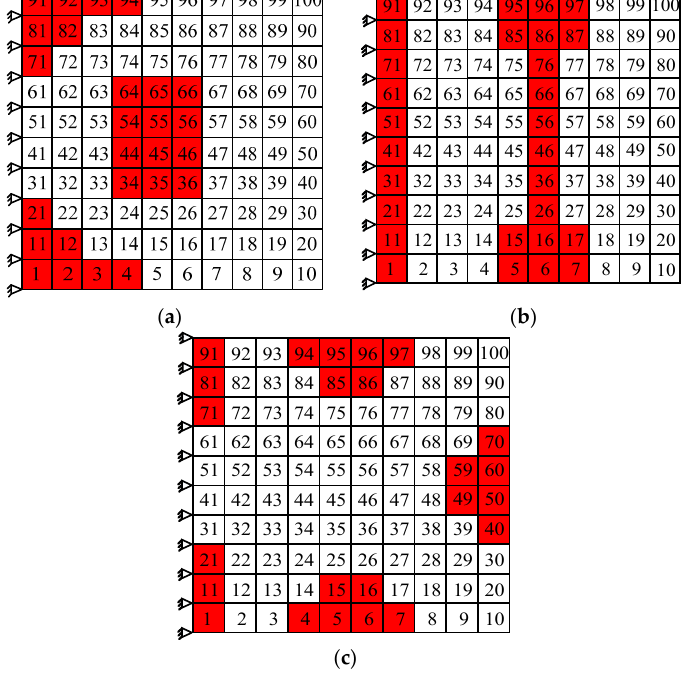
Figure 10. The damping optimization schemes for ( a ) the second order, ( b ) the third, and ( c ) fifth order.